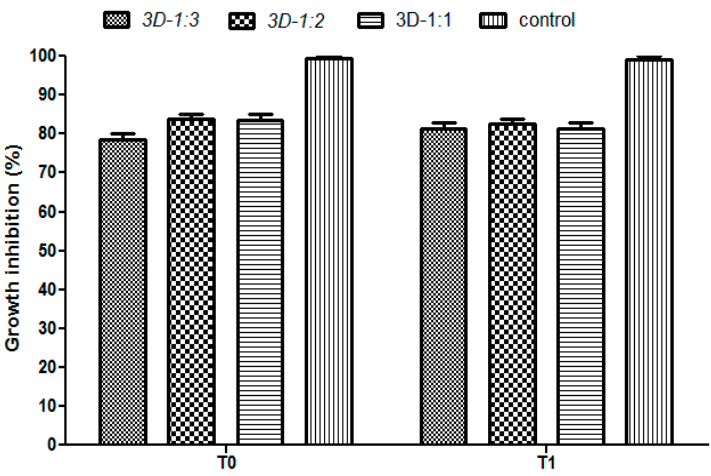
Figure 9. Antimicrobial activity of the 3D matrices quantified at T 0 and T 1 on P. aeruginosa .